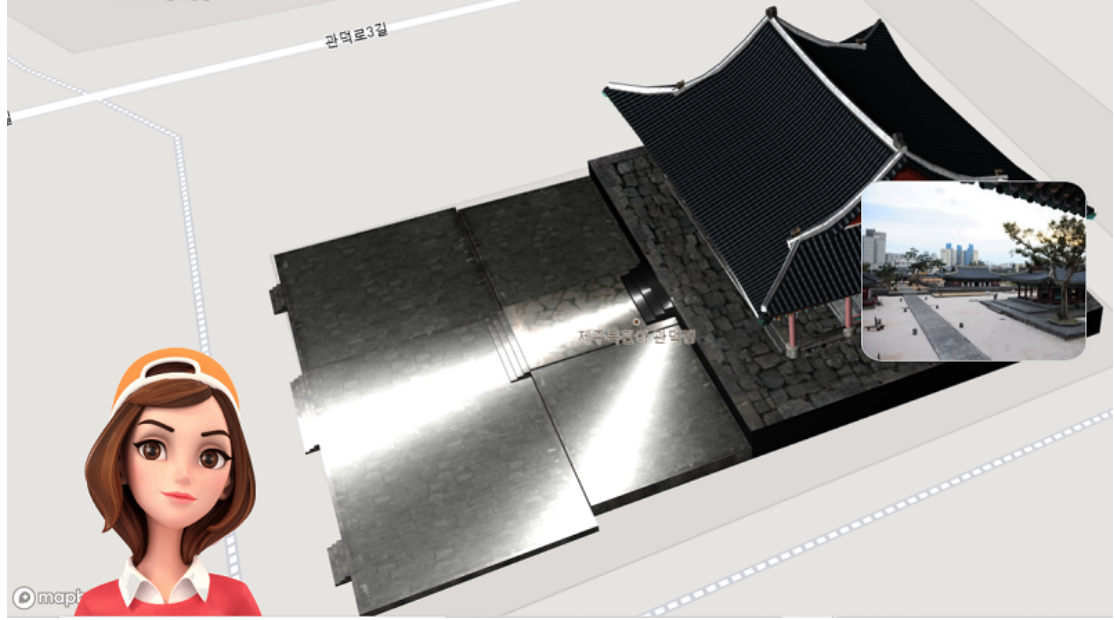
Figure 3. The 3D model of the heritage artifact is accurately positioned on the interactive